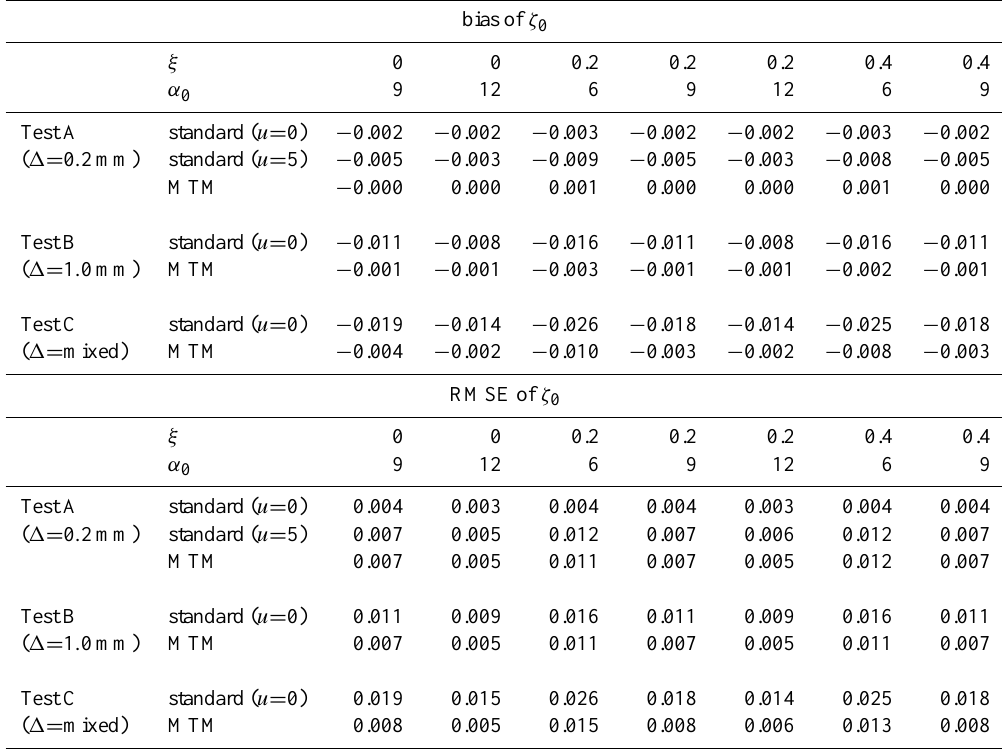
Table 3. Same as Table 1 but for ζ 0